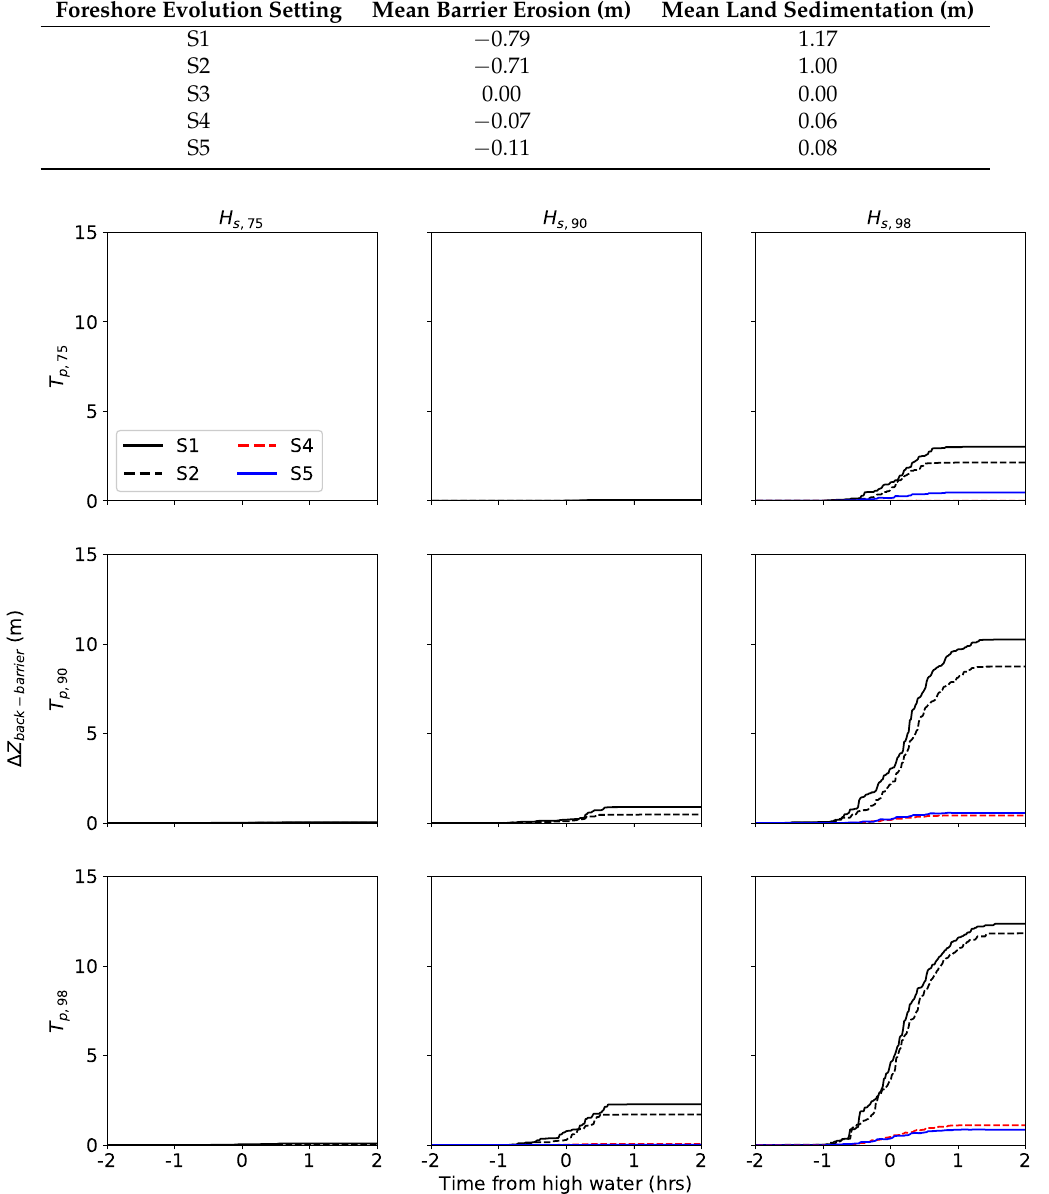
Figure 10. Cumulative integrated elevation change of the area from the base of the back barrier to the model’s landward boundary, using S1 to S5 for each H s and T p combination under the highest astronomical